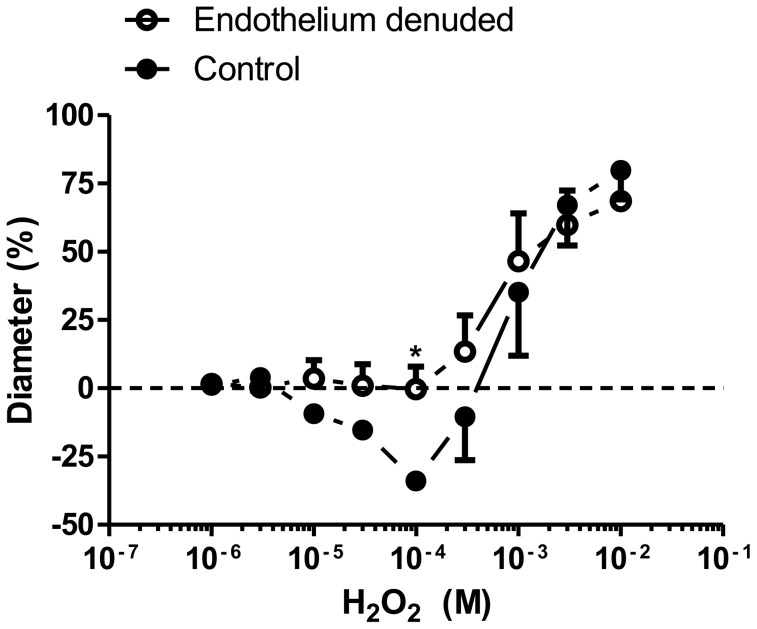
H2O2-induced vasoconstrictions are mediated by the endothelium in skeletal muscle arterioles.H2O2 concentration-response relationships were determined (as given in Fig. 1A) in intact (control, closed symbols, n = 6 from 6 different animals) and endothelium-denuded arterioles (id: 131±10 µm, open symbols, n = 5 arterioles from 5 different animals). The asterisk denotes a significant difference from the control.